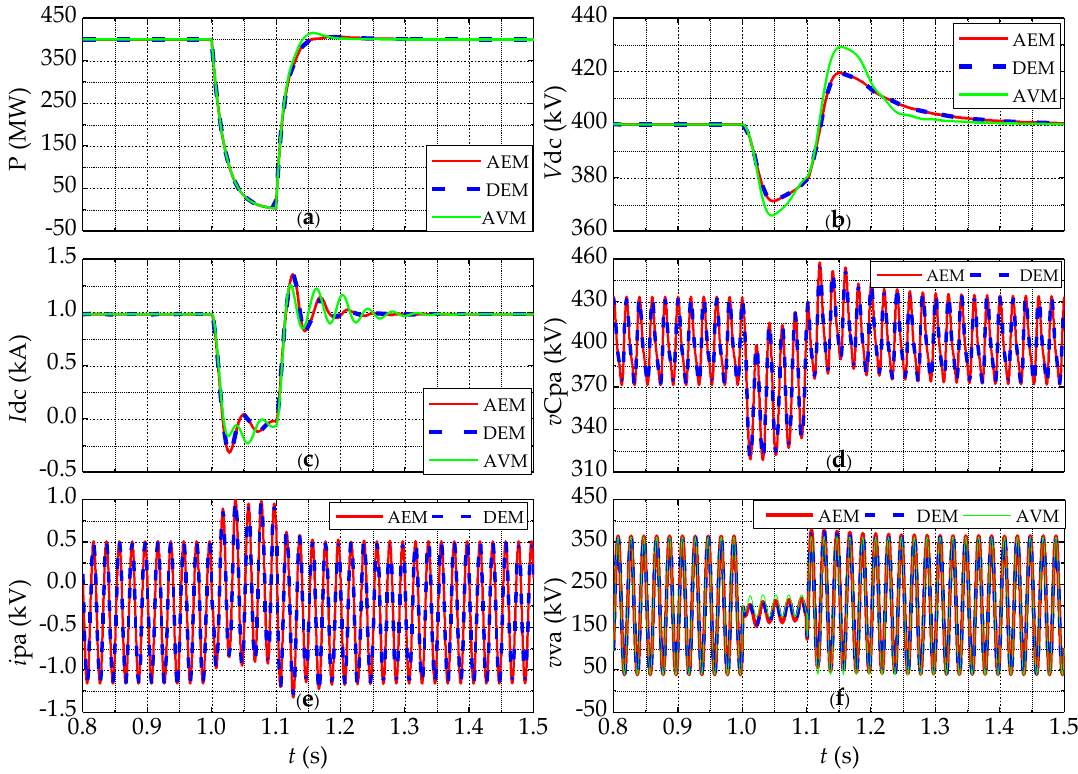
Figure 13. AC fault. ( a ) MMC1 active power; ( b ) DC voltage; ( c ) DC current; ( d ) SMs capacitor voltage; ( e ) Current in the upper arm in phase a ; ( f ) AC voltage in phase a at valve-side.